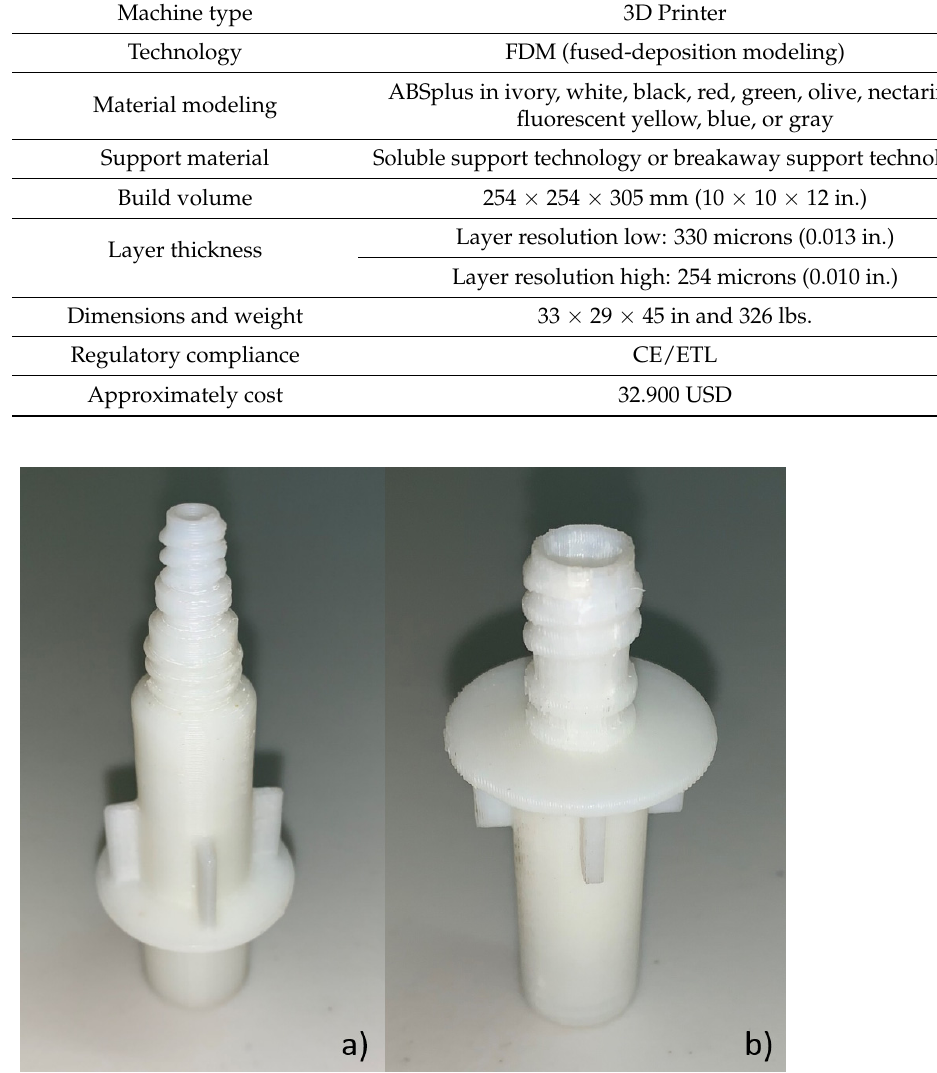
Figure 5. Acrylonitrile butadiene styrene (ABS) connector model: ( a ) BP plastic connector and ( b ) PB plastic connector. plastic